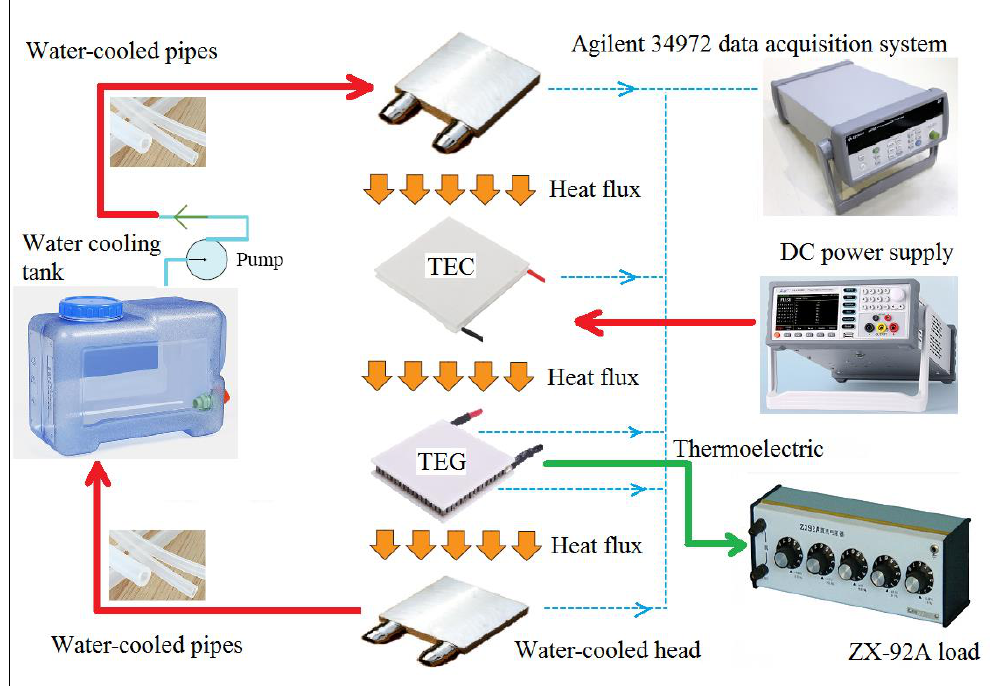
Figure 1. Schematic diagram of thermoelectric energy conversion system for heat recovery with circulating energy exchange water-cooling circuit.